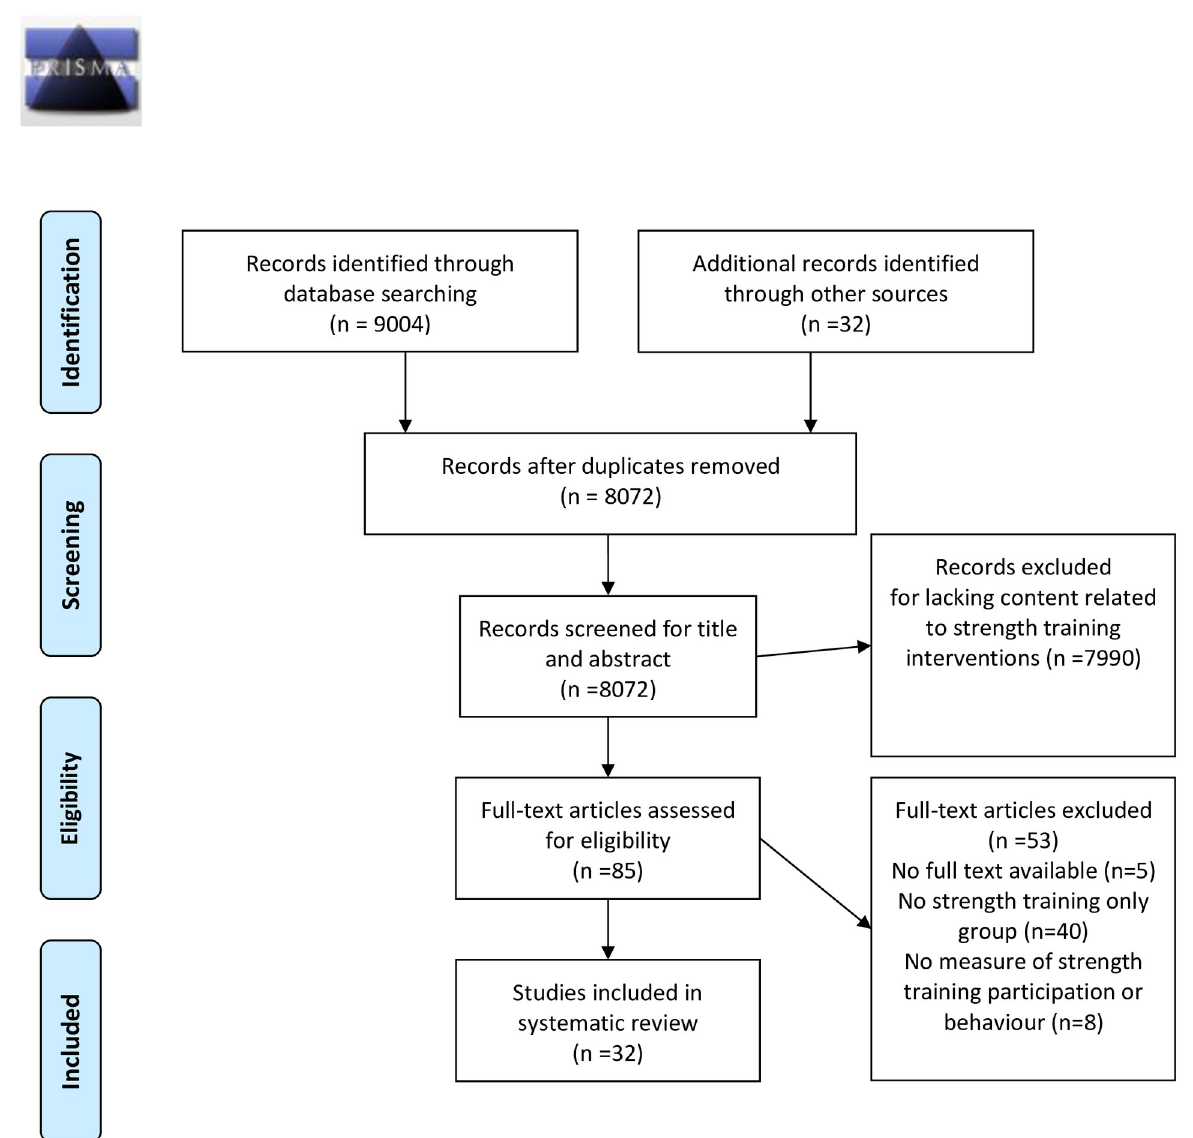
Fig 1. PRISMA flow